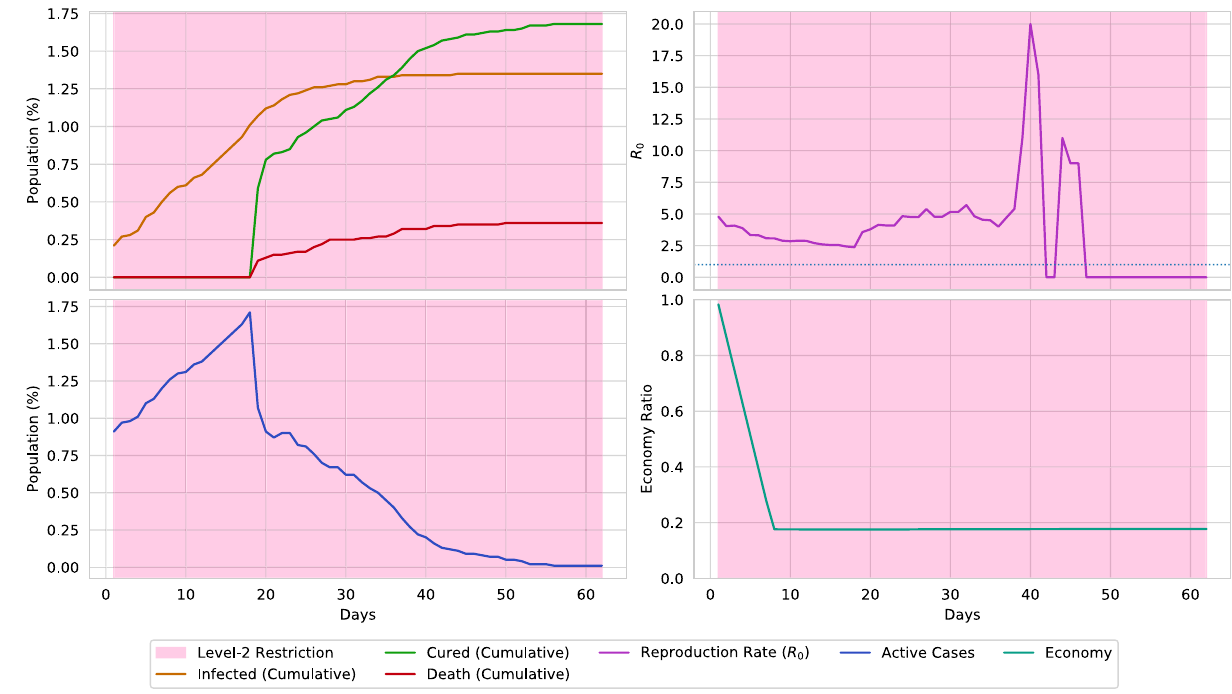
Figure 18. A simulation of the virtual environment if full lockdown is ordered. Due to strict lockdown, the spread of the virus fully stops after 60 days. However, this is almost impossible to occur in a real-world scenario. Furthermore, lockdown causes the economical ratio to be decreased to less than